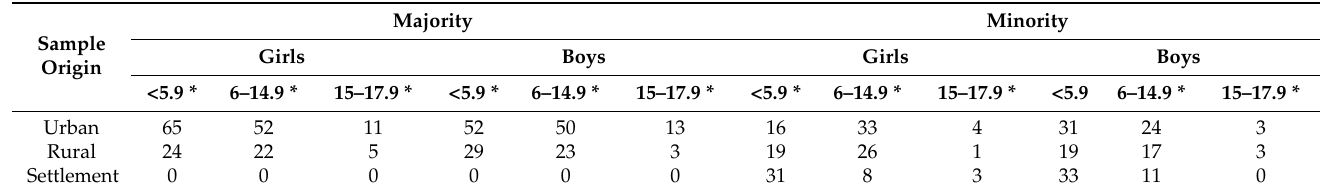
Table 1. Categories of origin, age classes, sex, and match with